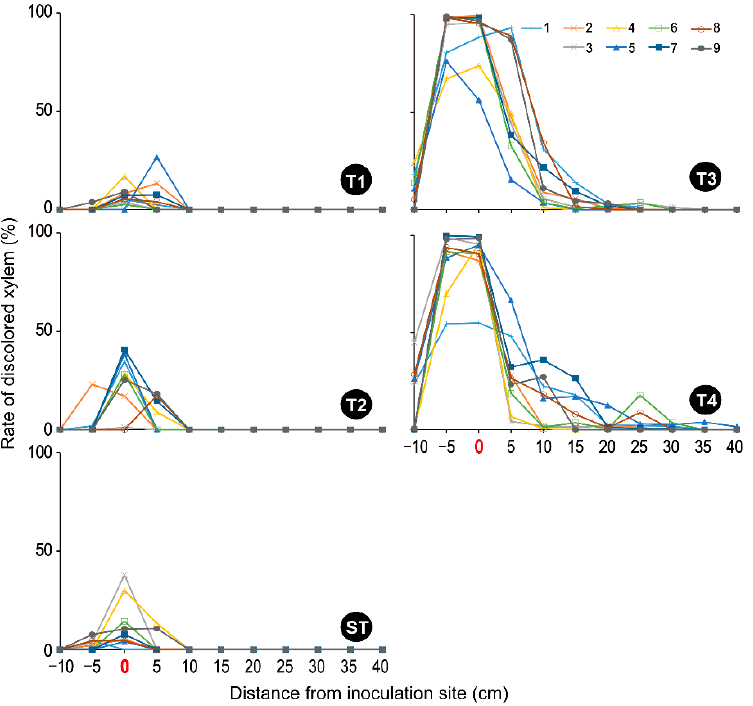
Figure 5. The rate of discolored xylem in each fig sapling tested. T1: F. kuroshium ; T2: N. metavorans ; T3: C. ficicola ; T4: F. kuroshium + C. ficicola ; ST: sterilized toothpicks; CT: none. The treatment information is shown in Table 1.